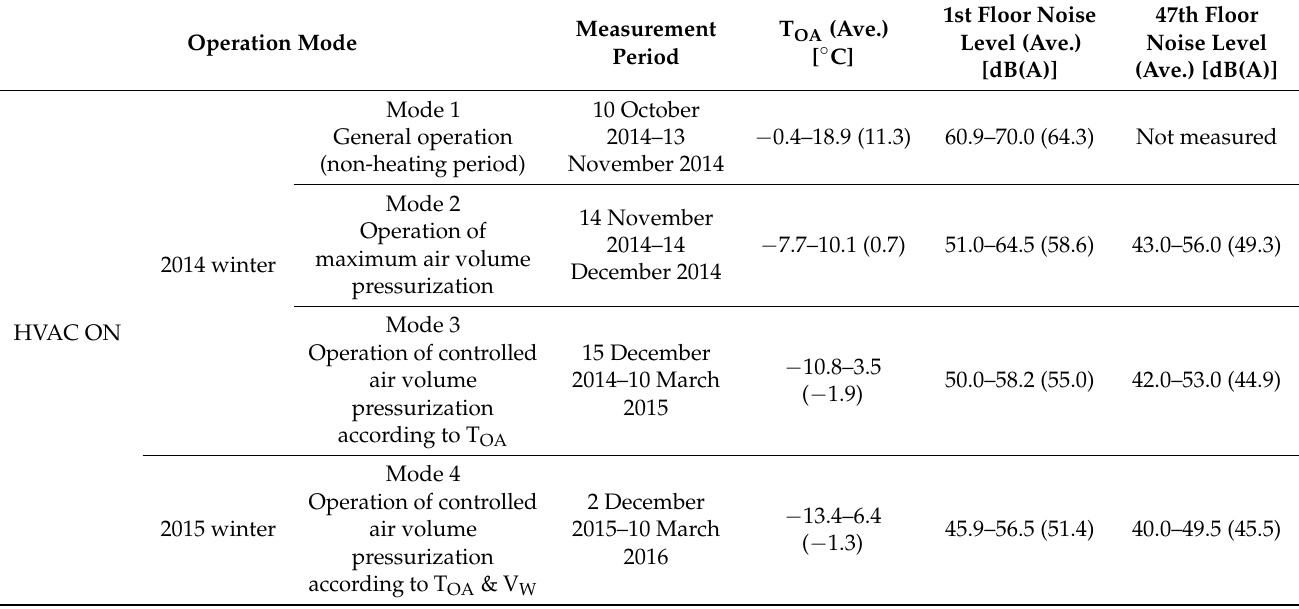
Table 5. Average NL on the 1st and 47th elevator halls according to different HVAC pressurization schemes in operation.